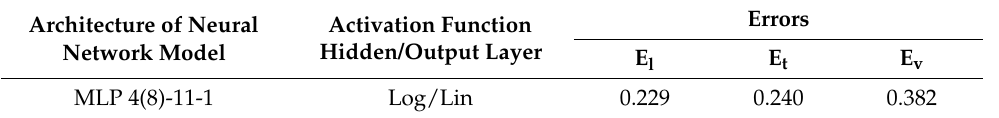
Table 6. The basic information on the structure and training (learning) (El), test (Et) and validation (Ev) error values of MLP neural network adopted as the model water–fat serum release from fresh pasta filata